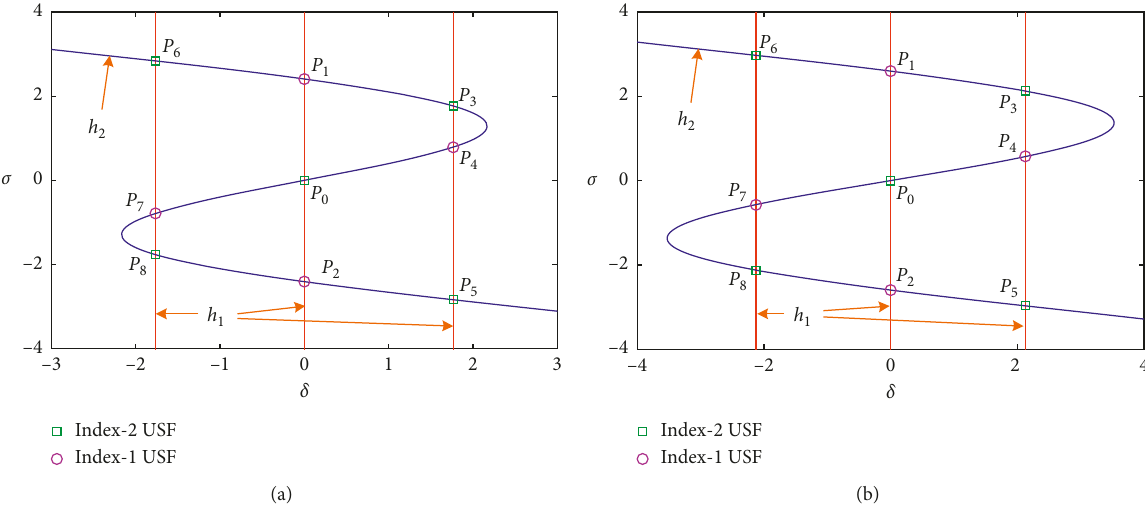
Figure 1: Values δ and σ of the equilibrium points by inspecting the intersections of two function curves h (a) k 3.6. (b) k 5. (cid:31) (cid:31) Table 1: Equilibrium points, eigenvalues, and stabilities for k